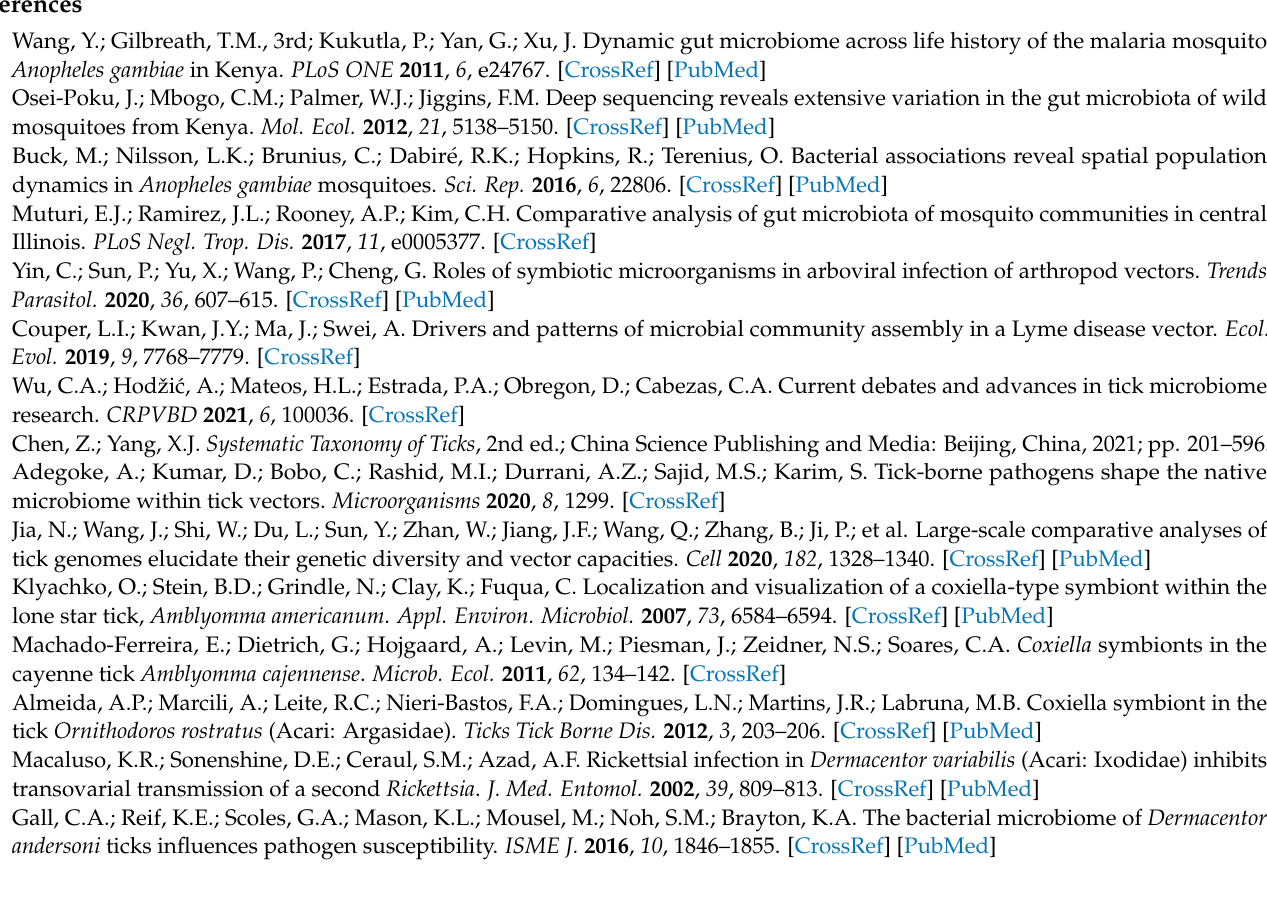
Figure S4: LEfSe conducted based on bacterial community in D. silvarum ; Figure S5: LEfSe conducted based on bacterial community in I. spersulcatus ; Figure S6: LEfSe conducted based on bacterial community in H. concinna ; Figure S7: Microbial interaction networks within ticks; Table S1: Complete OTU table with read counts from each individual